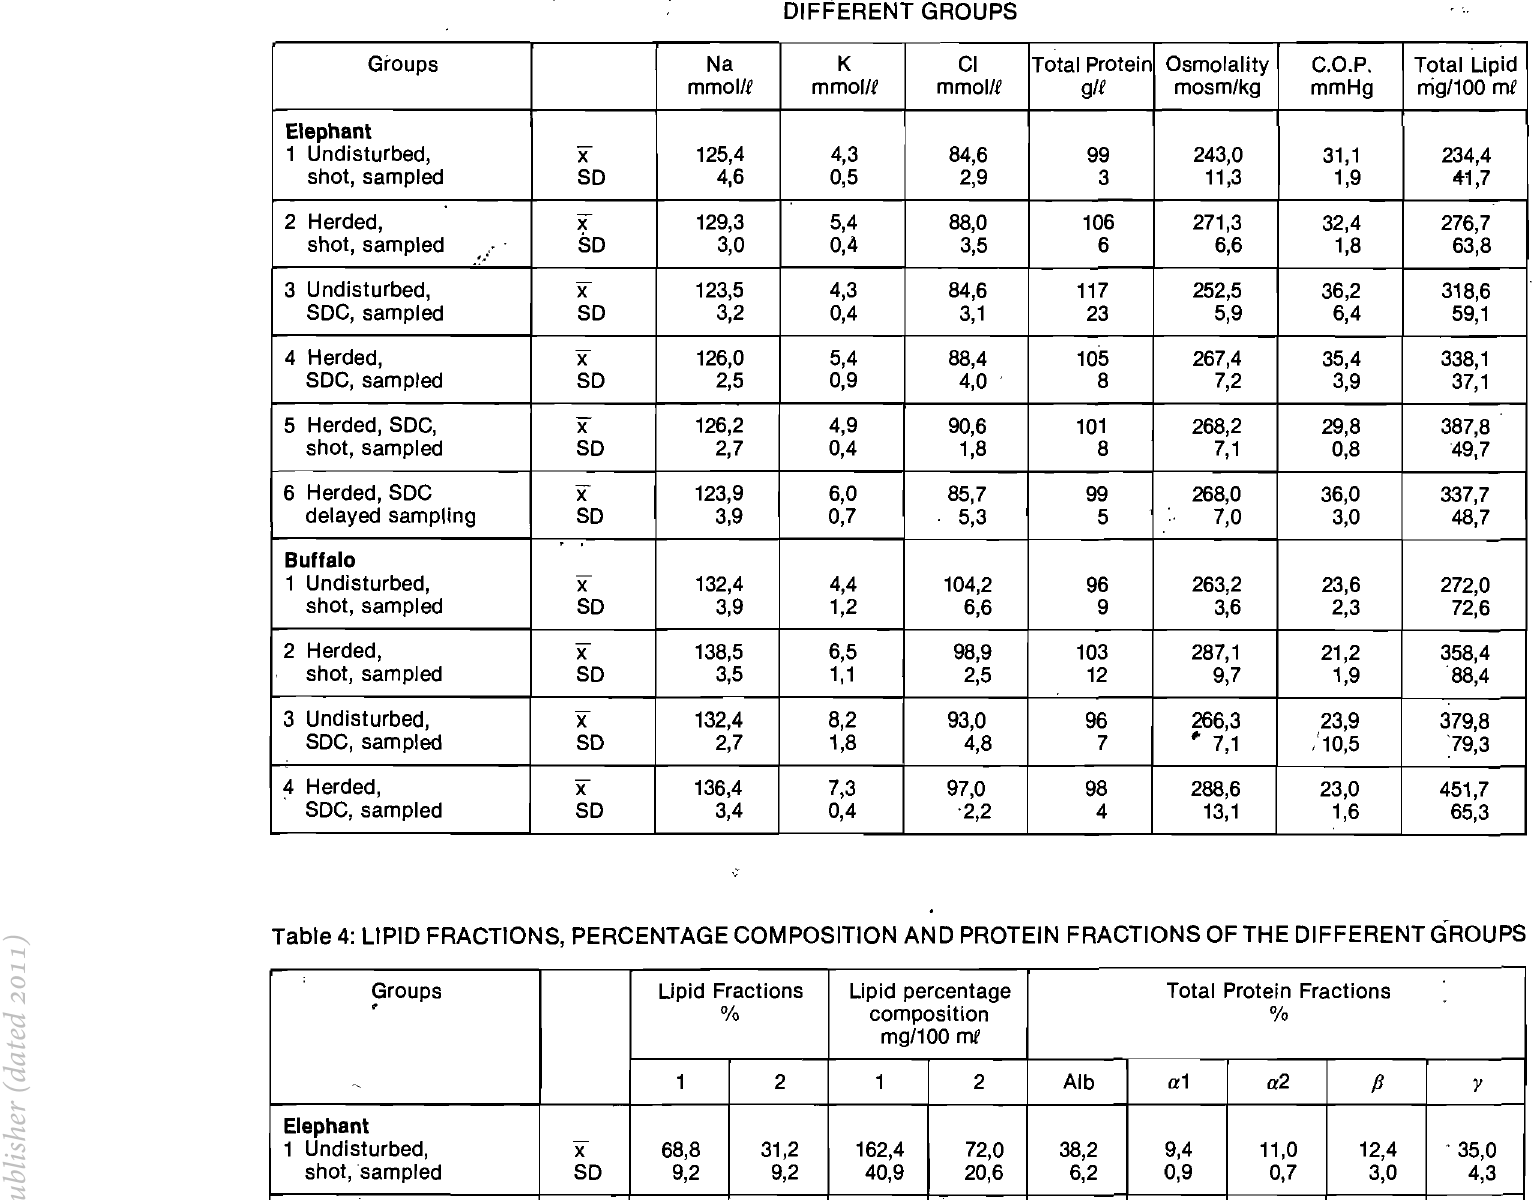
Table 3: ELECTROLYTE, PROTEIN, OSMOLALITY, COLLOID OSMOTIC PRESSURE AND LIPID VALUES OF THE DIFFERENT GROUPS Groups